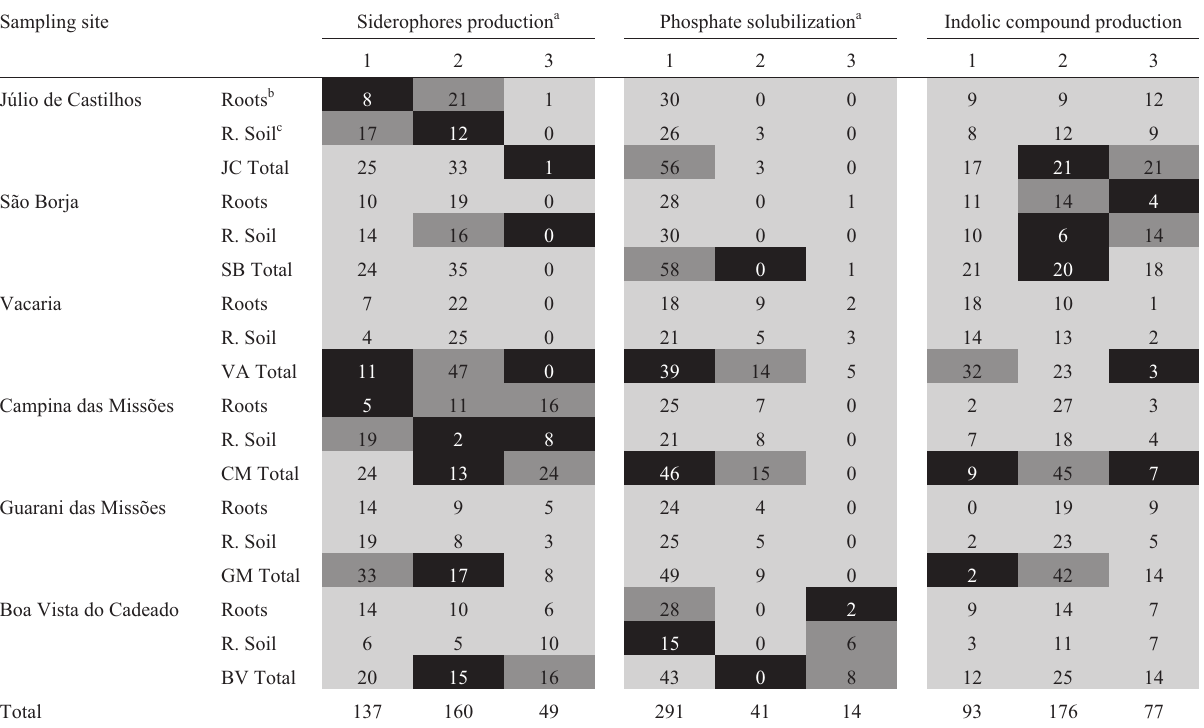
Table 3 - Heatmap associations of bacterial isolates and PGP traits both from roots and rhizospheric soil from each sampling site. Different shades show whether a certain location had more or fewer bacteria than expected. or whether there was no association. Black cells = number of isolates lower than ex- pected in that condition, dark shaded cells = number of isolates higher than expected in that condition, light shaded cells = no significant differences be- tween observed and expected values according to adjusted residual analysis ( p